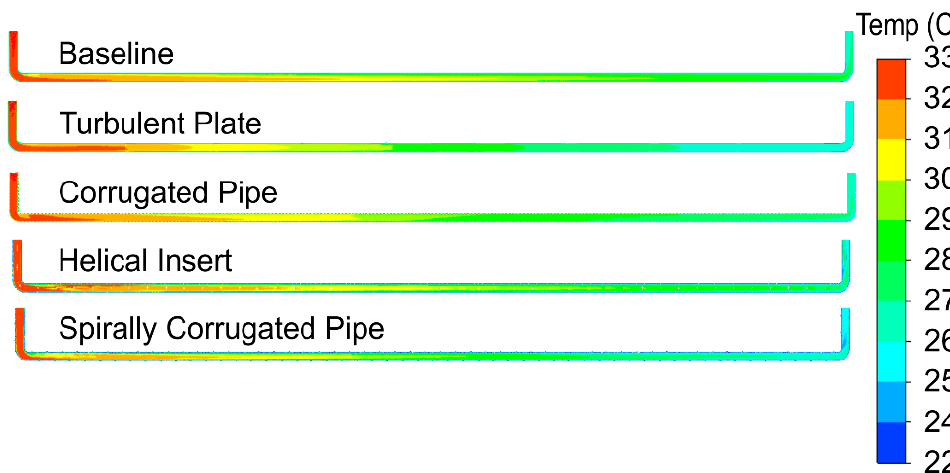
Figure 14. Temperature profile in the middle plane for five investigated pipes.